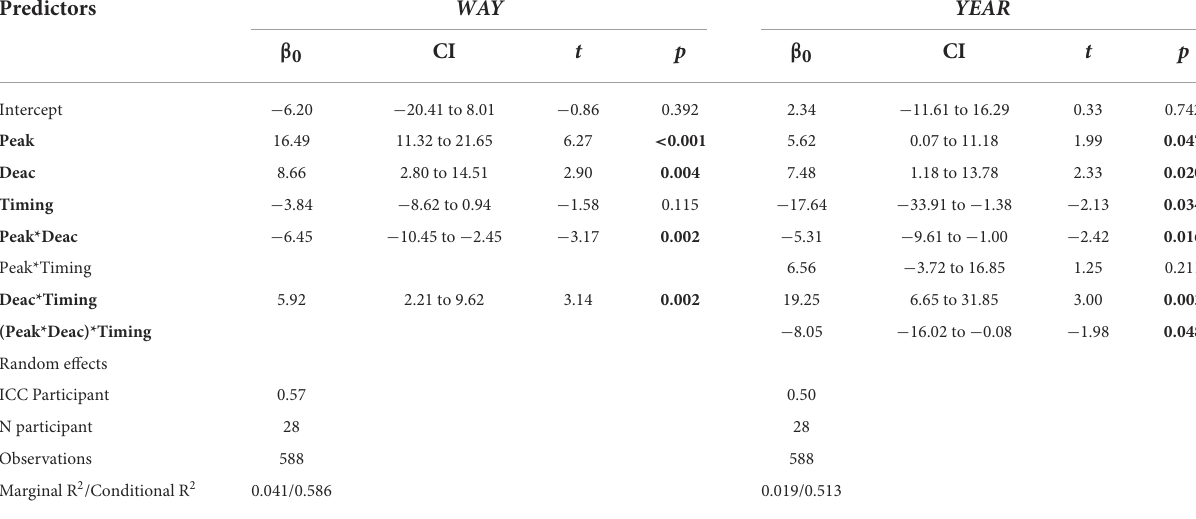
TABLE 6 Estimated coefficients, confidence intervals and t values for the mixed effect model with types of manipulation as fixed factors fitted to the magnitude of to the perceived prominence magnitude data (baseline-normalized) in Test 2.